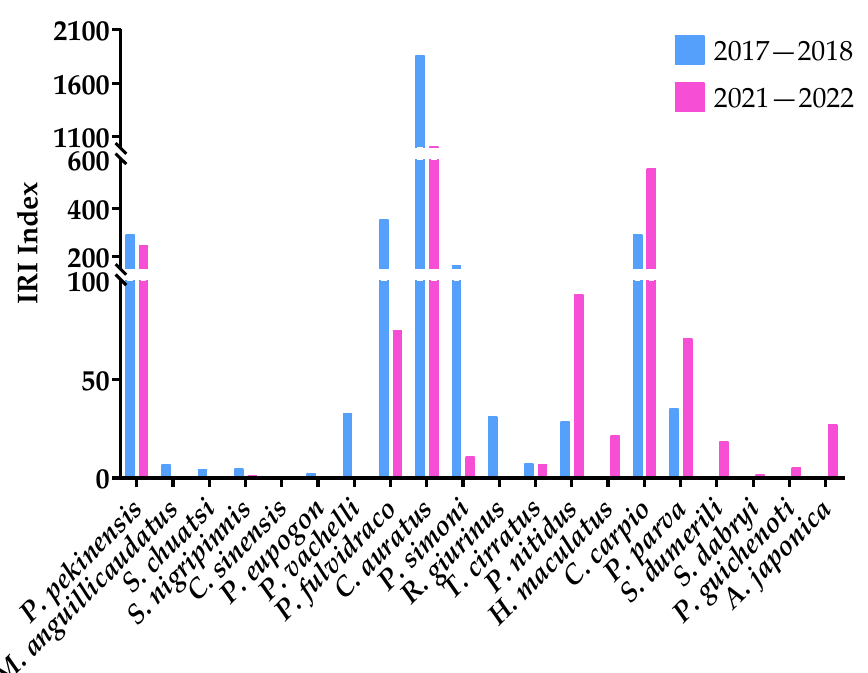
Figure 6. The IRI of bottom fish in the southern seine area of Gehu Lake in 2017–2018 and 2021–2022.